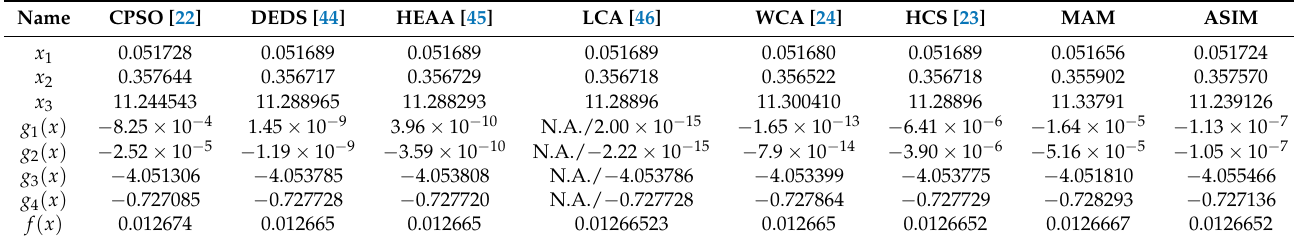
Figure 6. First and final fitness values in ASIM for solving the tension/compression spring. Table 7. Comparison of the best solutions obtained by various studies for the tension/compression spring design optimiza- tion problem.